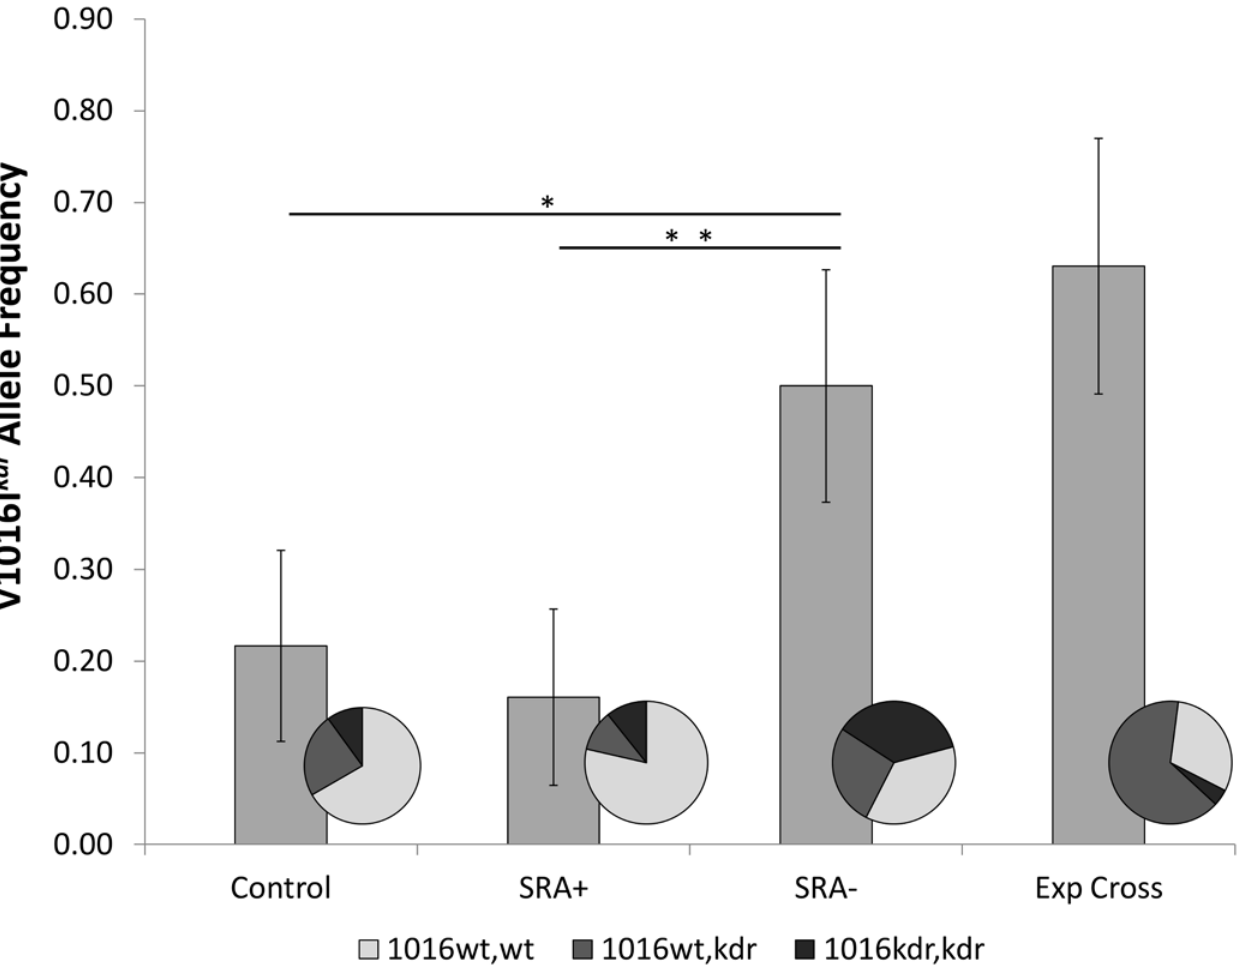
Fig 5. V1016I kdr allele frequencies in F9 control, SRA+, SRA-, and experimental cross progeny cohorts. Bars indicate overall V1016I kdr allele frequencies in samples of 30 mosquitoes from each mosquito strain. * = significant difference, P < 0 . 01 . Inlaid pie charts indicate the proportions of each cohort that were wt homozygous, wt/kdr heterozygous and homozygous kdr at position